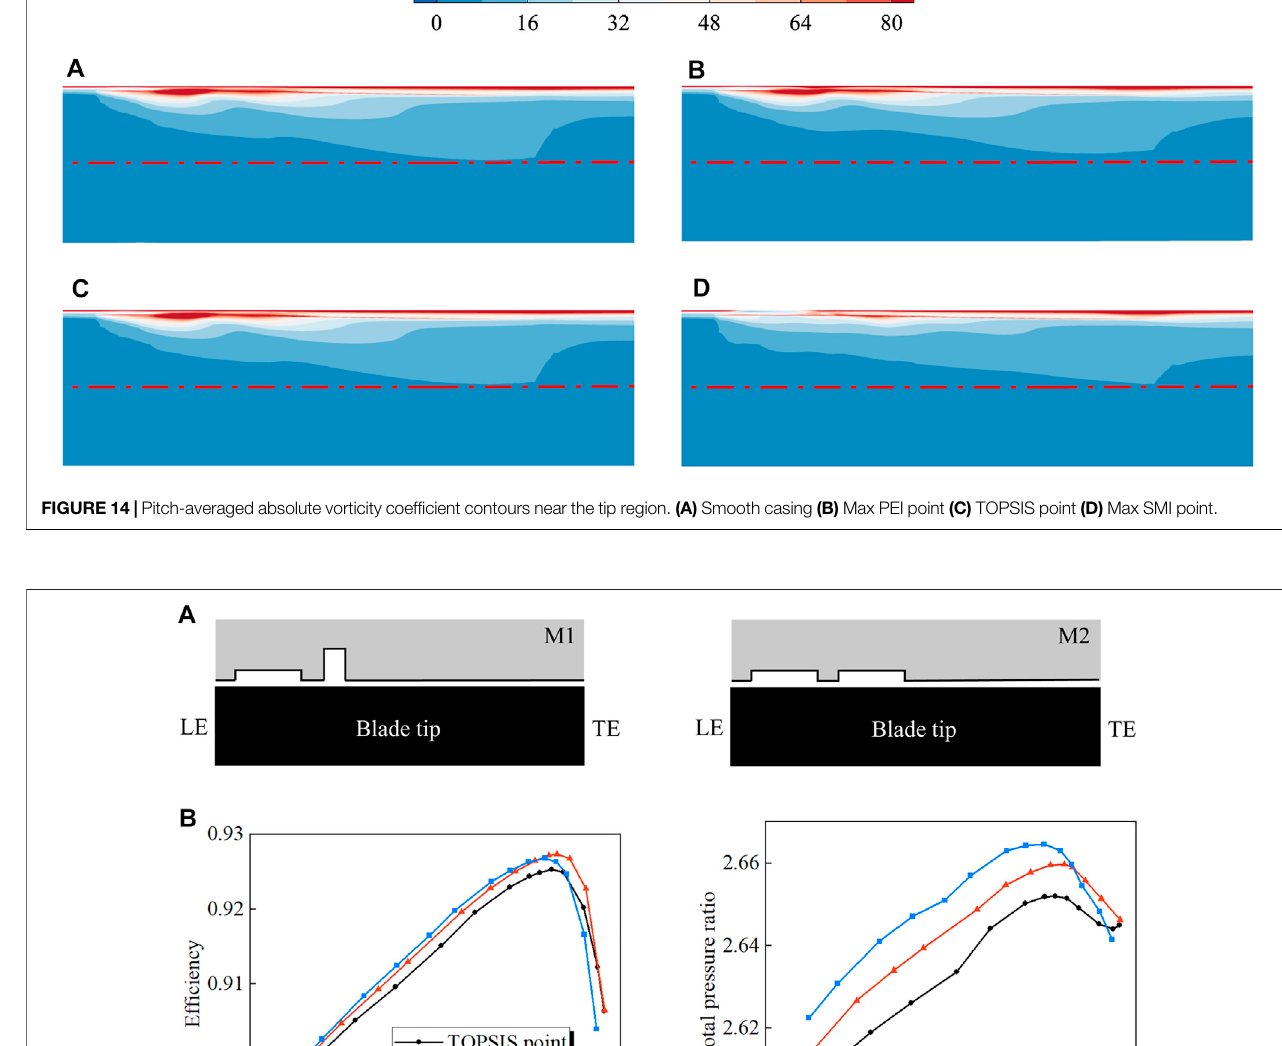
The red dash-dotted line in the fi gure represents the lower boundary of the high absolute vorticity region in the smooth casing condition. As expected, the high vorticity region is reduced at the max PEI point. In order to quantify the intensity of TLV, the integral of the pitch averaged absolute vorticity at the meridional plane is calculated. The integral values of the max PEI, TOPSIS, and SMI points are 0.0629, 0.0633, and 0.0632, respectively. Compared to